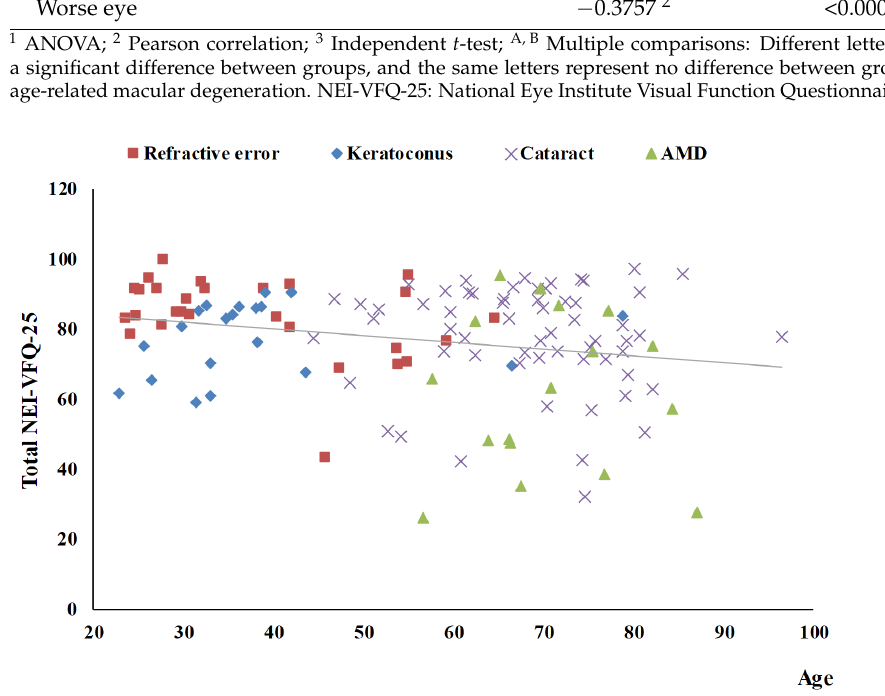
Figure 1. The scatter plot between total NEI-VFQ-25 score and age (r = − 0.22, p = 0.0118).